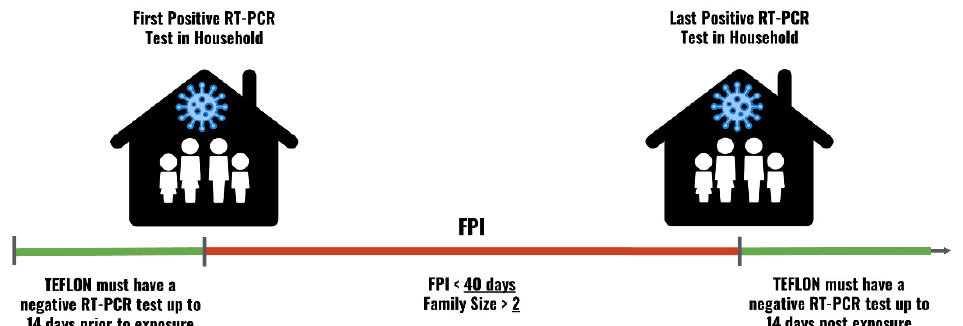
Figure 2. The minimal set of criteria that defined TEFLONs in relation to exposure events in the household, or the Familial Positive Interval (FPI). The horizontal line is comprised of three time frames. The first period (green) was denoted by the pre-exposure negative reverse transcription polymerase chain reaction (RT-PCR) test date, which had to fall within a 14-day interval prior to the exposure event, or the FPI. The middle period (red) was the duration of the FPI. The final period was defined by the time between the last documented exposure to a household member, and a TEFLON’s negative RT-PCR test, or proof of non-infection (green).